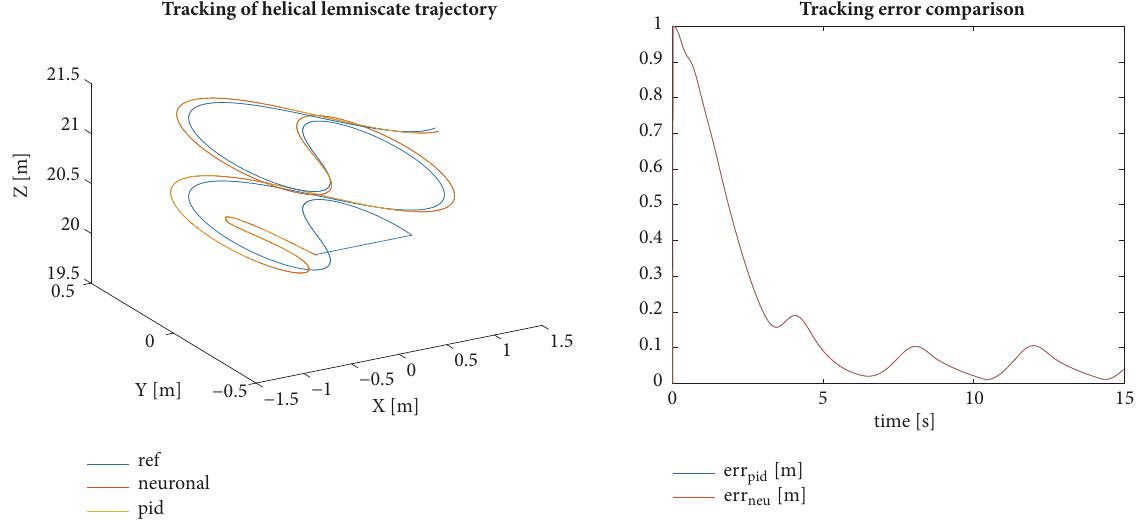
Figure 11: UAV tracking of a helical lemniscate trajectory (left) and its tracking error (right).